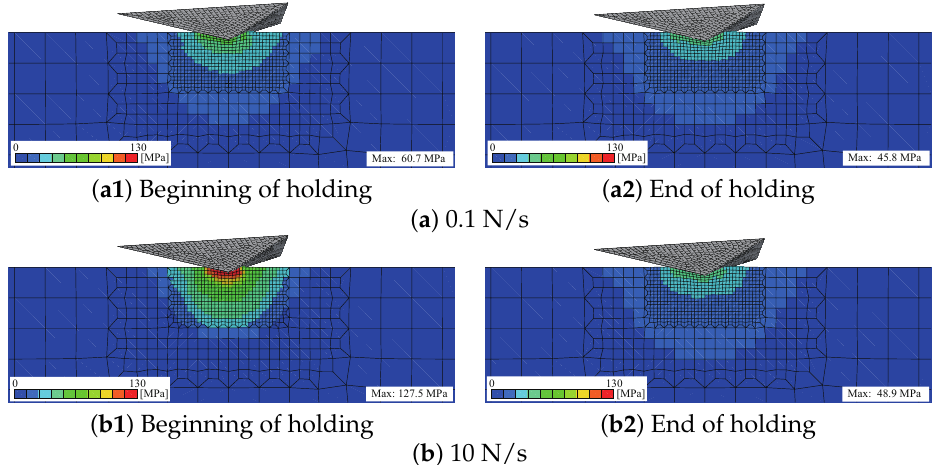
Figure 6. von Mises stress distribution at the beginning and end of the holding processes in the computational simulations using the determined material constants for α ∈ ( 0,1 )